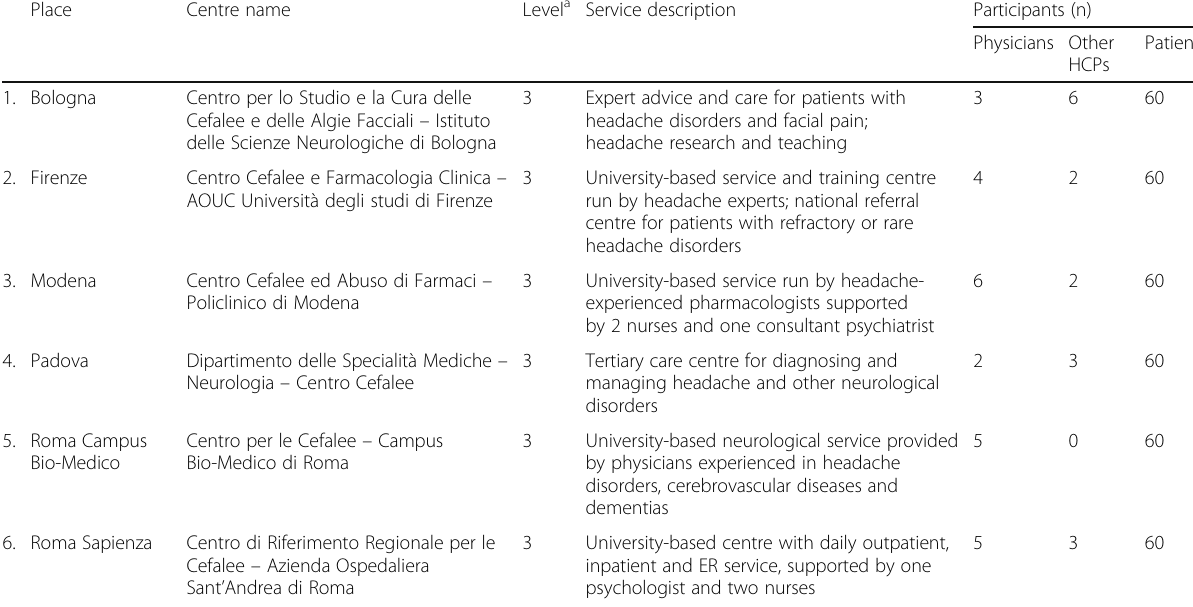
Table 1 Characteristics of participating headache centres